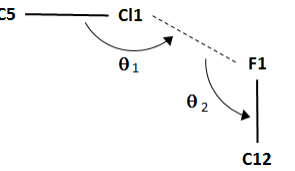
Figure 3. Part of the crystal structure of 3 , showing the formation of C(6) chains along (100). (Symmetry code: (iii) x − 1,y,z].